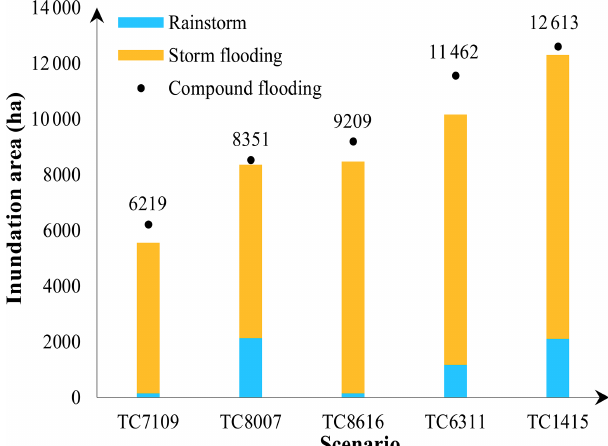
Figure 8. The comparison of the overall inundation area of rain- storm, storm flooding, and compound flooding in each TC